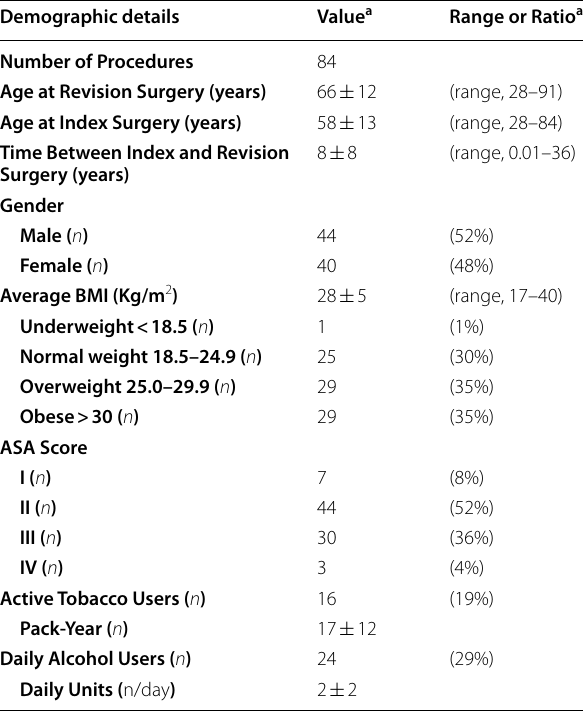
a Values are given as numbers and percentages, or average values with standard deviation and ranges